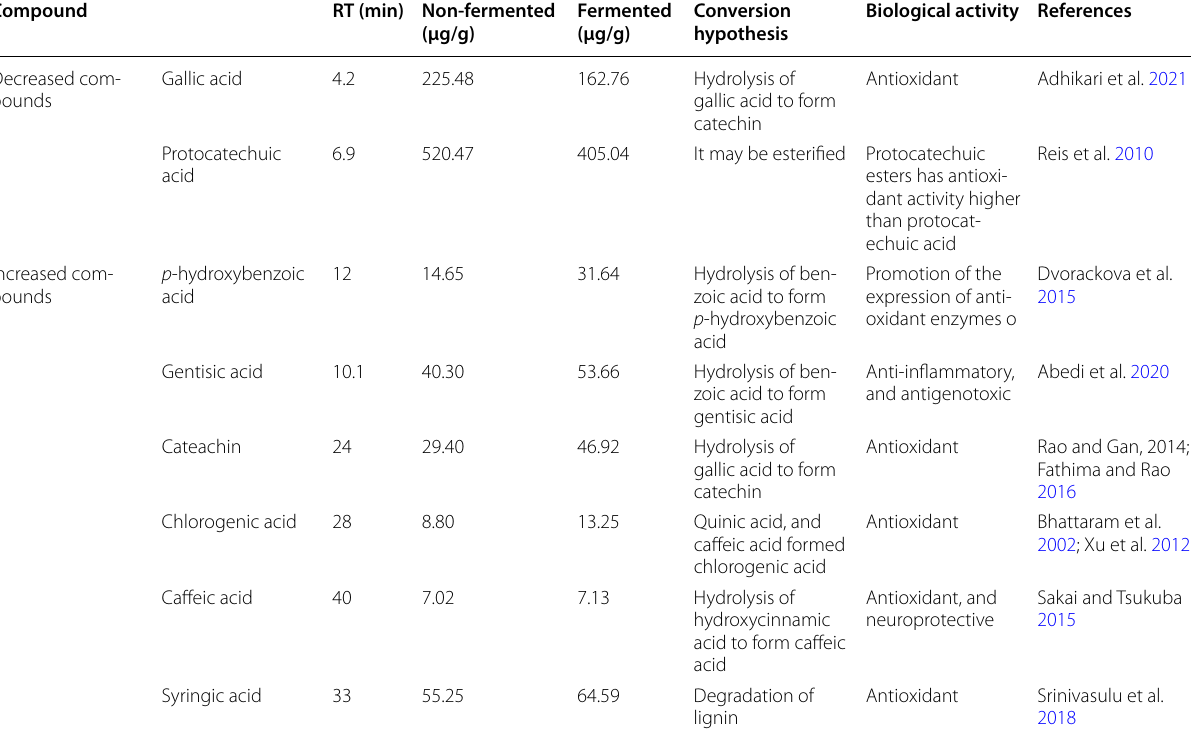
Table 6 Differentiation between some bioactive compounds in lyophilized extract of S. cerevisiae- fermented and non‑fermented cinnamon